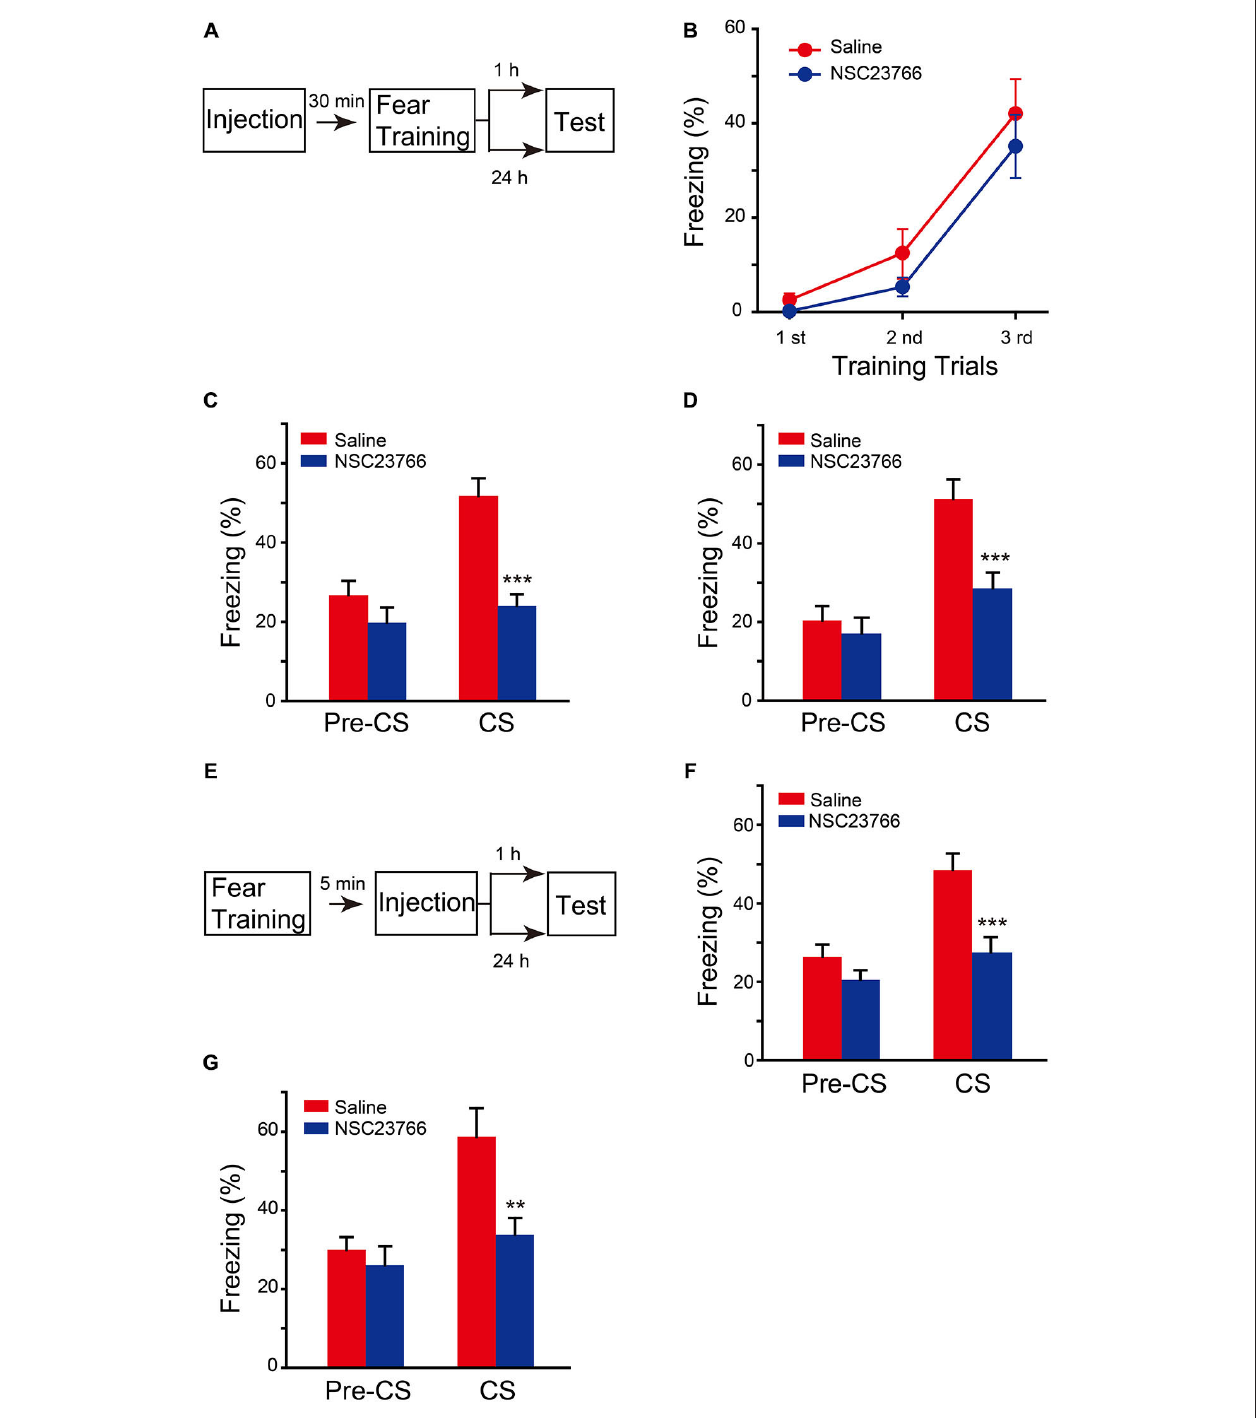
FIGURE 4 | Inhibition of Rac1 activity in BLA disrupted STM and LTM of fear conditioning . (A) Experimental design for (B–D) . 30 min after NSC23766 injection, mice were subjected to fear conditioning training followed by 1 h or 24 h memory test. (B) The freezing levels during each tone in training session (Saline: n = 8, NSC23766: n = 11). (C,D) Inhibition of Rac1 activity in BLA decreased the freezing levels at 1 h ( C , n = 7 of each group, ∗∗∗ p < 0.001) and 24 h ( D , Saline: n = 10, NSC23766: n = 8, ∗∗∗ p < 0.001) auditory fear memory tests. (E) Experimental design for (F,G) . NSC23766 was injected 5 min after fear conditioning training and the memory test was performed 1 h or 24 h post training. (F,G) Post-training inhibition of Rac1 activity in BLA decreased the freezing levels at 1 h (Saline: n = 11, NSC23766: n = 10, ∗∗∗ p < 0.001) and 24 h (Saline: n = 6, NSC23766: n = 8, ∗∗ p < 0.01) auditory fear memory test.